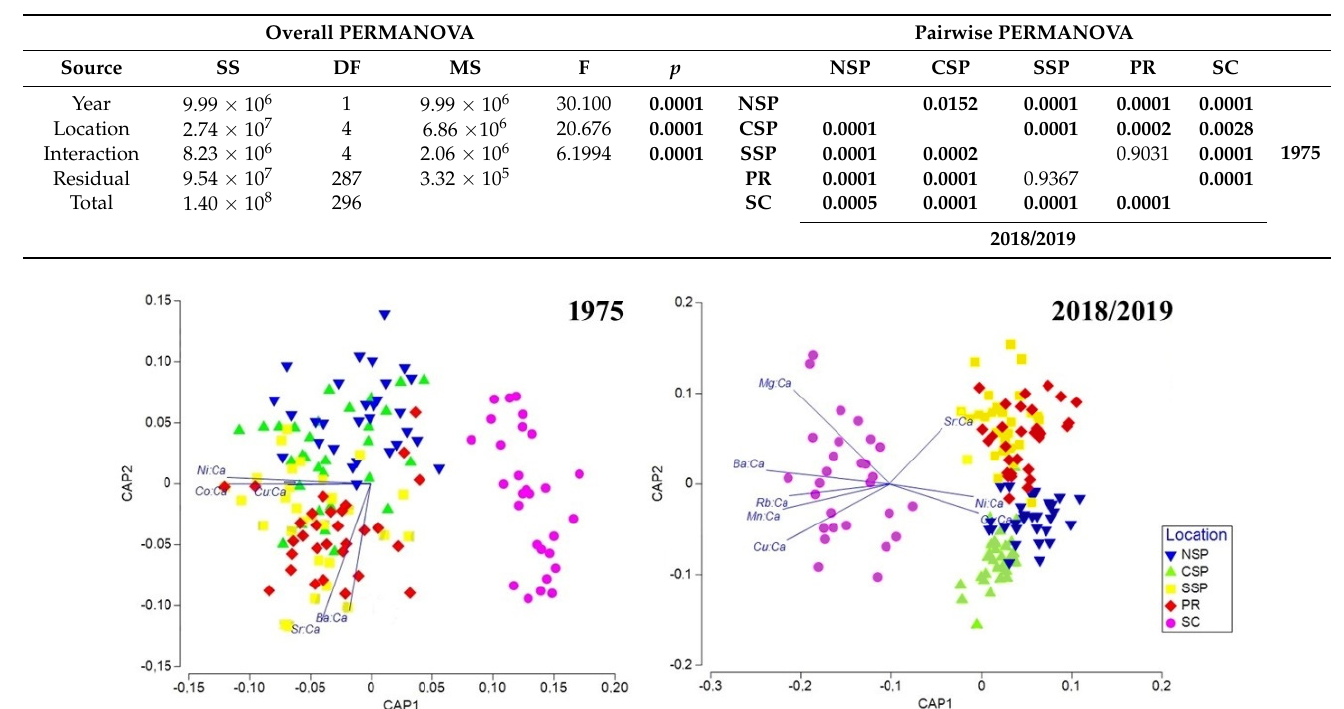
8 of 16 Table 3. Overall and pairwise PERMANOVA comparisons among the five sampling locations re- garding the chemical composition of Isopisthus parvipinnis otoliths collected in 1975 and 2018/2019. Significant statistical differences ( p < 0.05) were marked in bold. Legend: North of São Paulo (NSP), Center of São Paulo (CSP), South of São Paulo (SSP), Paraná (PR), Santa Catarina (SC).